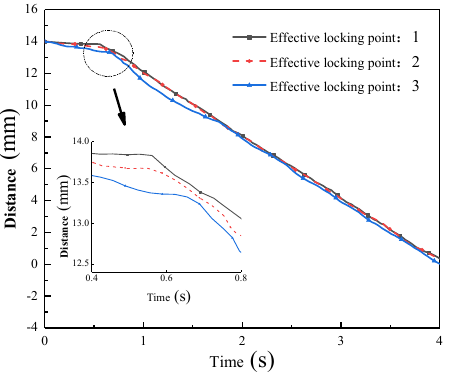
Figure 14. Spatial distance variation of locking process with different numbers of effective locking points.